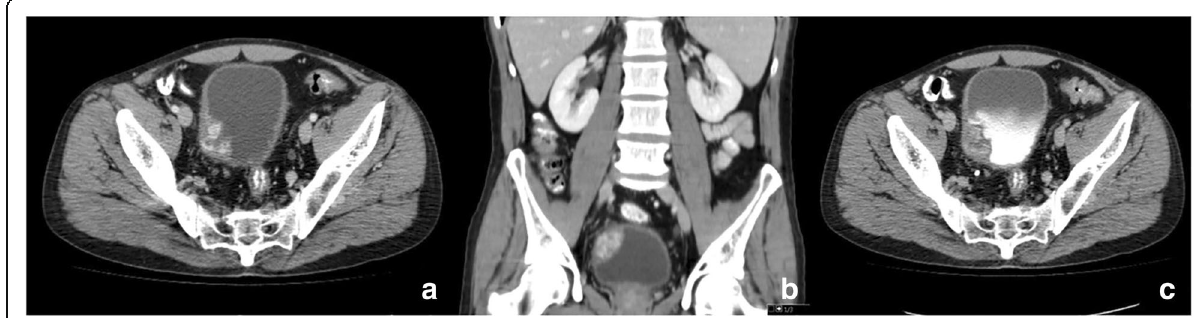
Fig. 5 SFT of the bladder. Axial ( a ) and coronal ( b ) CT images showing a int raves i cal heterogeneous vascularized mass. In the late phase axial images ( c ) the lobular contour is more conspicuous